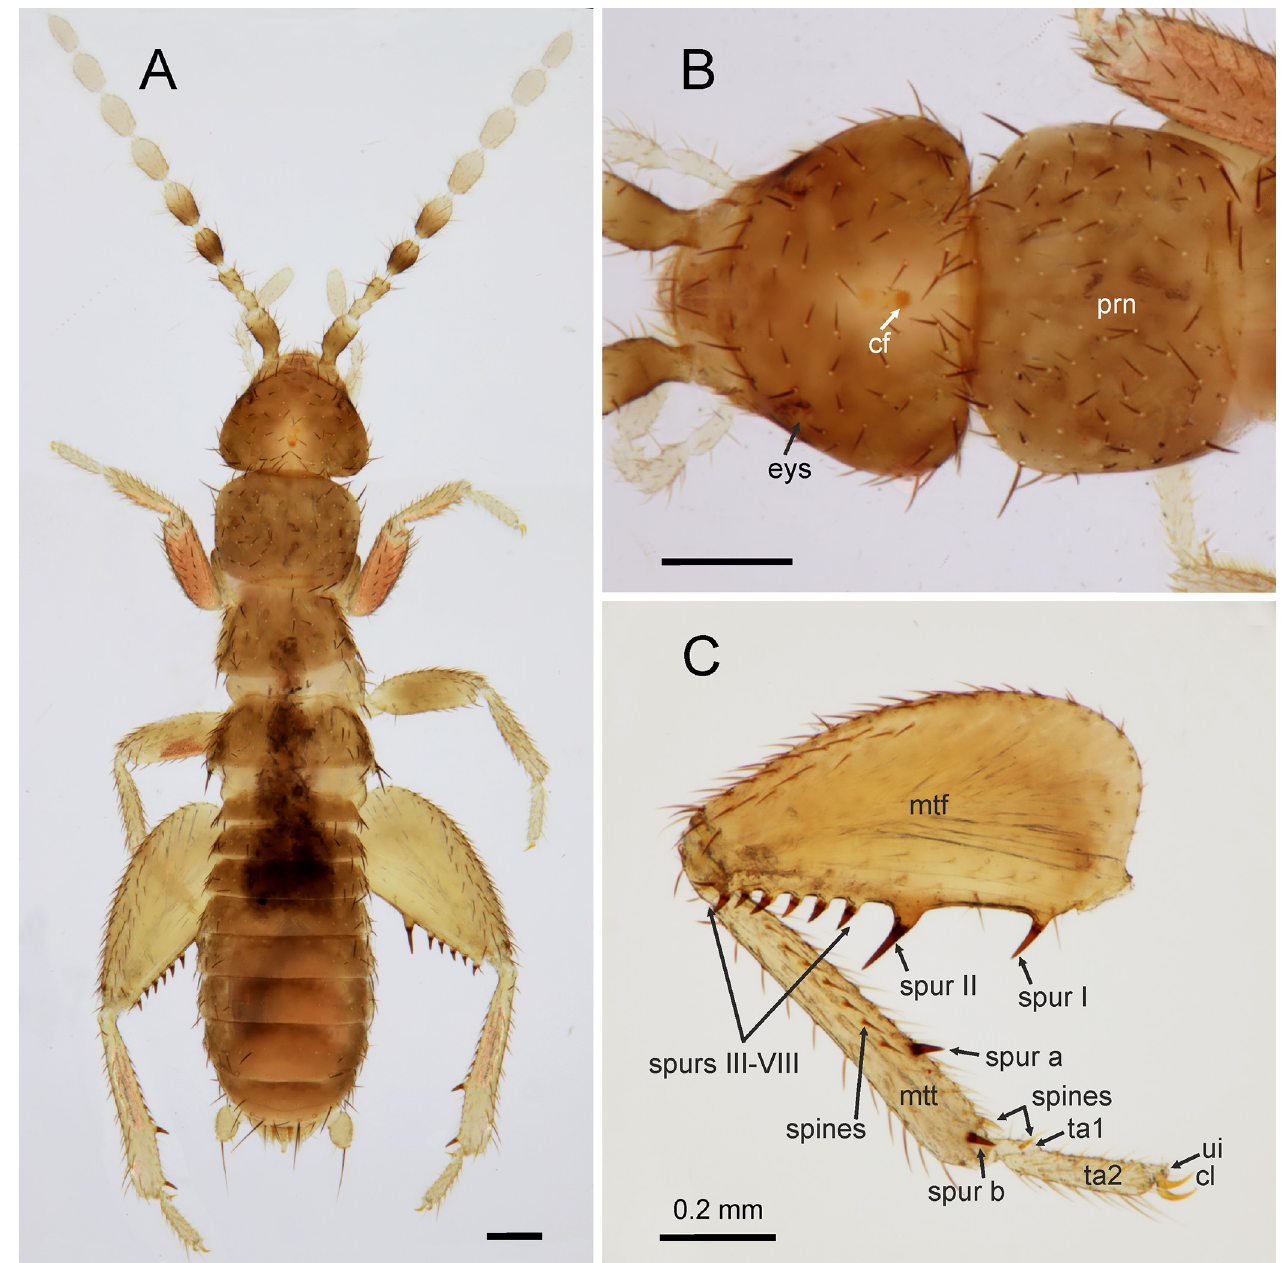
Fig 1. Latinozoros cacaoensis sp. nov., apterous male paratype. A: Dorsal view; B: Dorsal view of head and pronotum; C: Left metaleg, anterior view. Abbreviations: cl–clavus; ui–unguitractor plate; eys–eye spot; cf–cephalic gland; prn–pronotum; mtf–metafemur; mtt–metatibia; ta–tarsus. Scale bars = 0.2